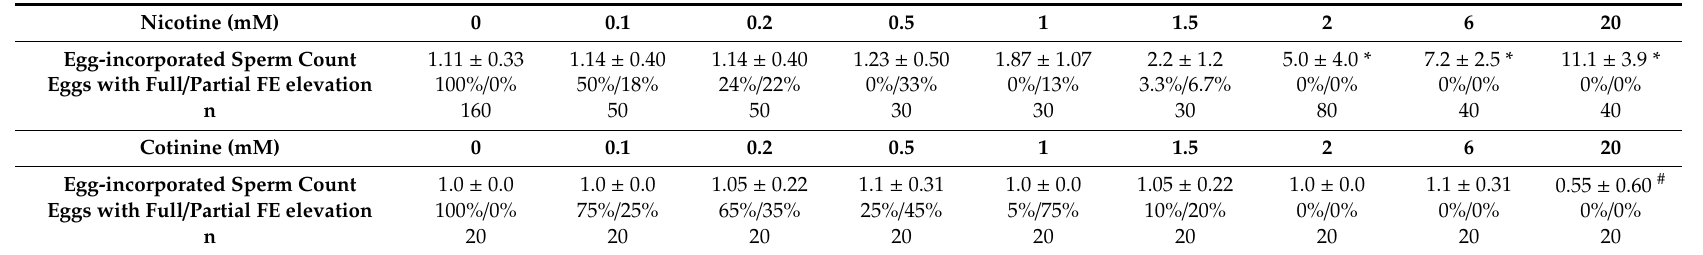
Table 1. E ff ects of nicotine and cotinine on the fertilization of P. lividus